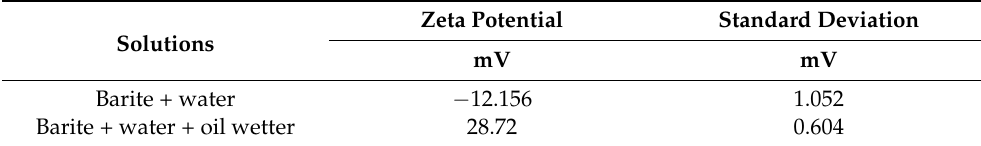
Table 3. Zeta potential